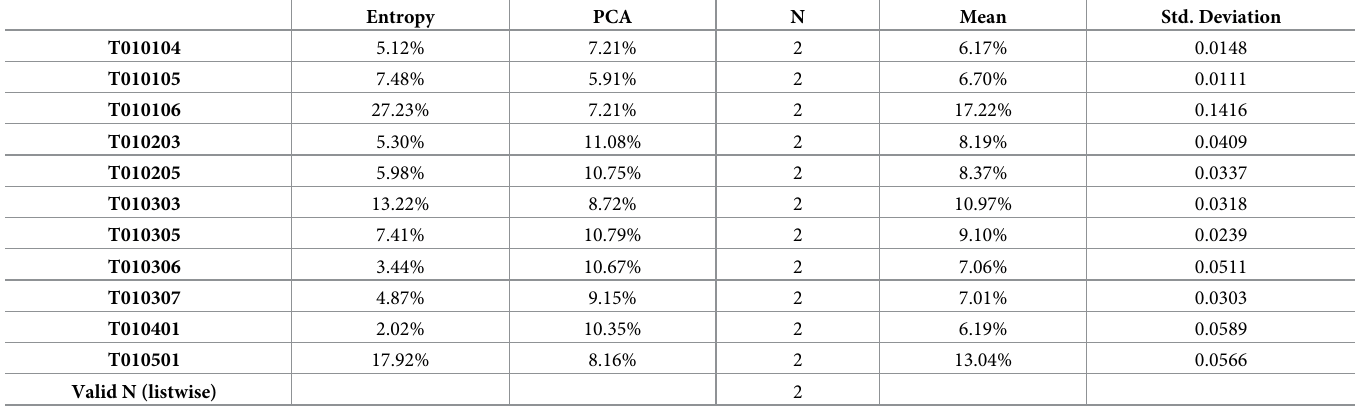
methods adopted to Case Study 2. For the weights to T010104, the minimum value is 0.0512; the maximum value is 0.0721; the mean value is 0.0617; the standard deviation is 0.0148. For the weights to T010105, the minimum value is 0.0591; the maximum value is 0.0748; the mean value is 0.067; the standard deviation is 0.0111. For the weights to T010106, the minimum Table 9. Descriptive on standard deviation to Case Study